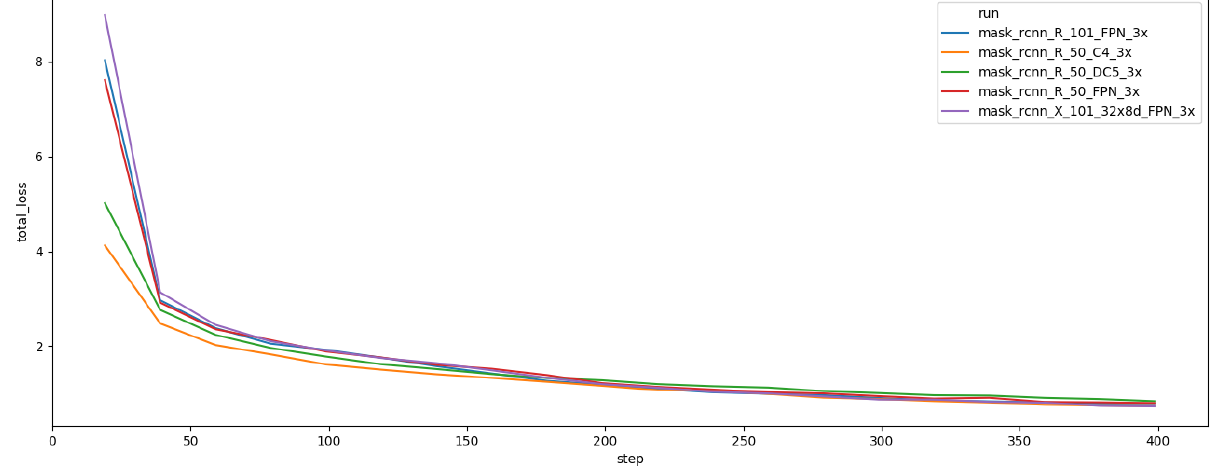
Figure 11. Loss rate.